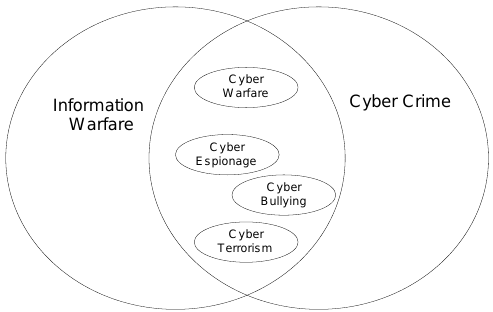
Figure 1. Information warfare as a combination of traditional information warfare and cyber-crime. This view is adopted in this